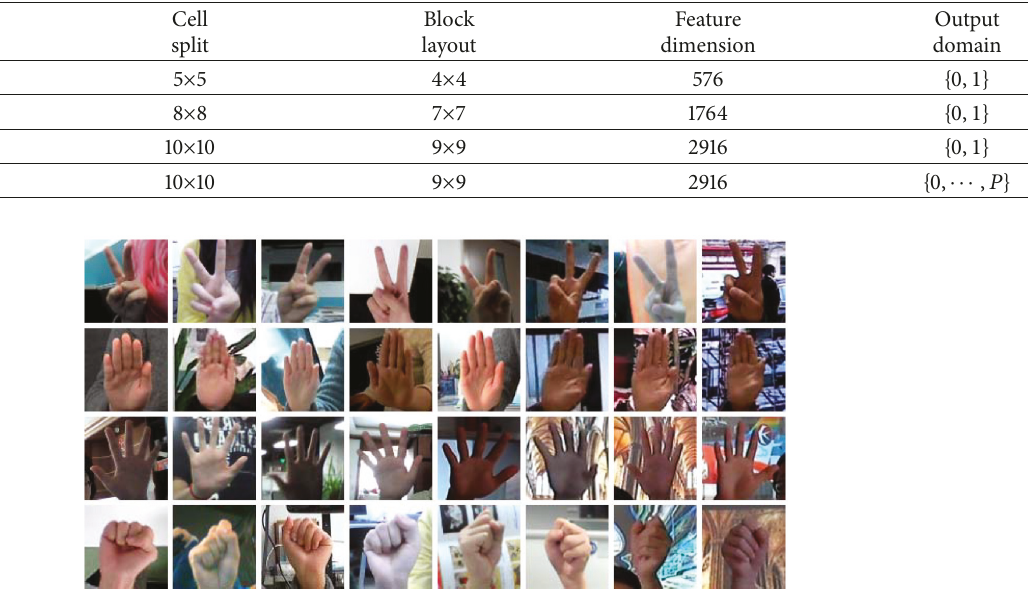
Figure 2: Examples for the four hand posture categories used in our experiments. From the first to the fourth row, the four posture categories are, respectively, denoted as vict , close , open , and fist .